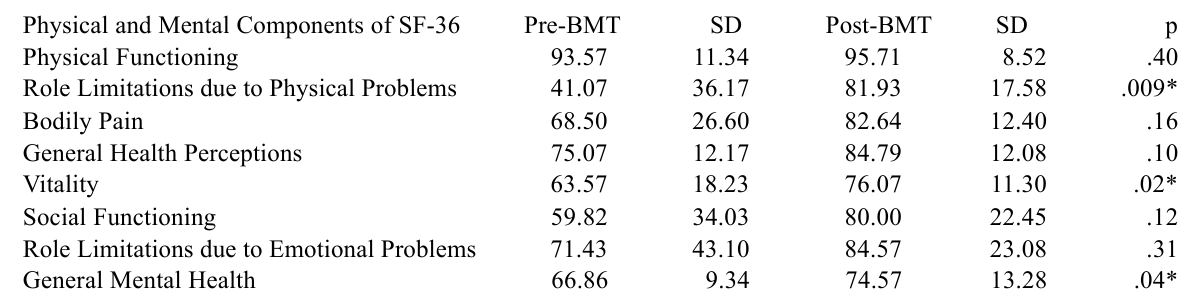
Means, Standard Deviations and Probability of the SF-36 Variables Determined by the Wilcoxon Test in the Group (N = 14) Before and After HSCT Physical and Mental Components of